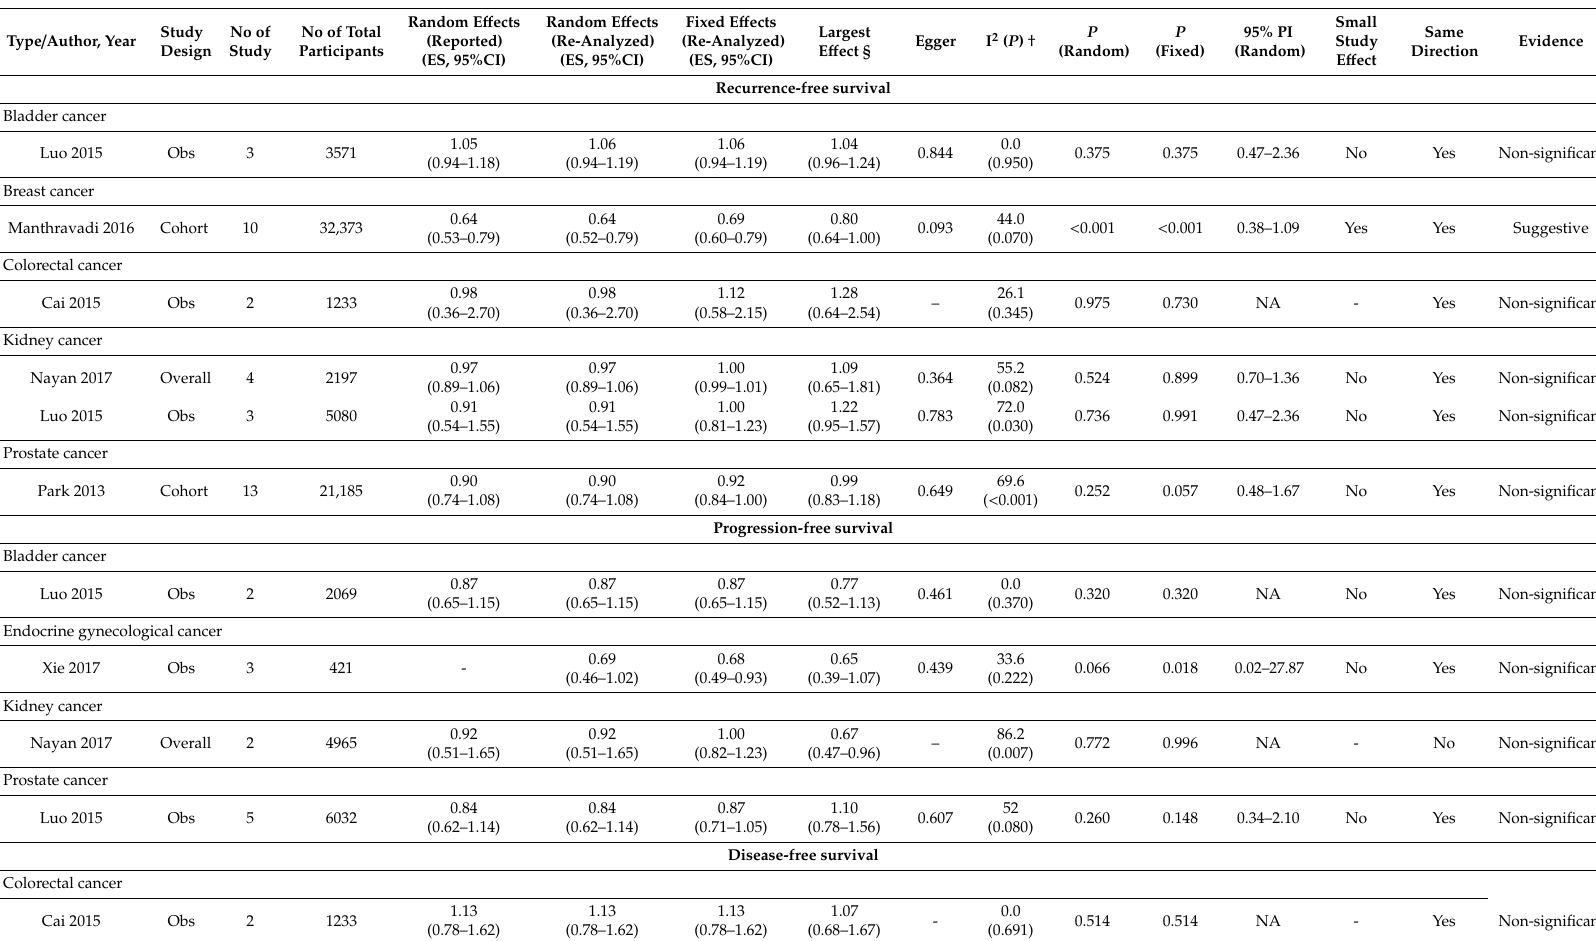
Table 3. Summary of each individual meta-analysis on associations of the use of statin and recurrence-free survival, progression-free survival and disease-free survival in various cancers.